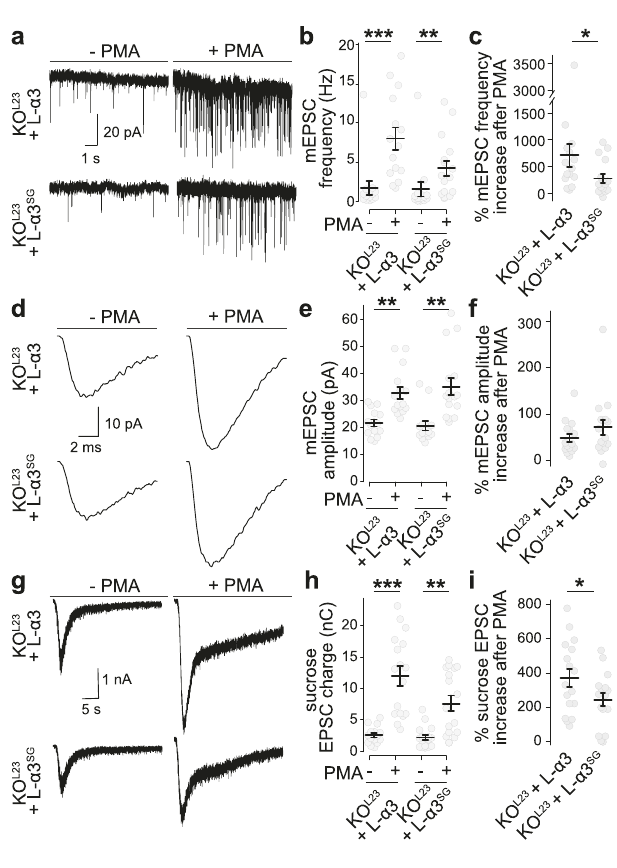
Fig. 3h – j, active zone levels of these proteins, but not of Bassoon,